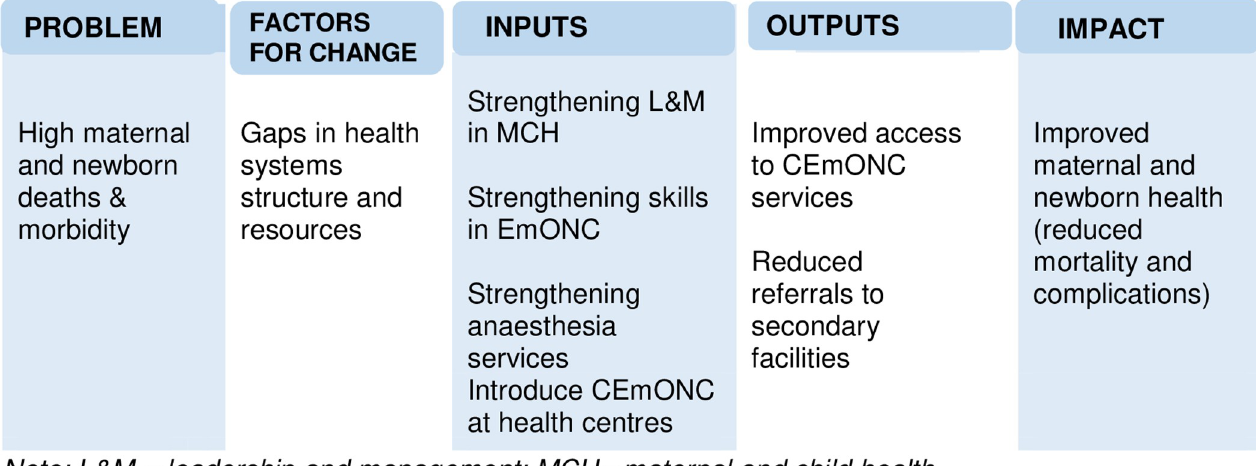
Fig 1. The theory of change for improved maternal and newborn health care in the ASDIT